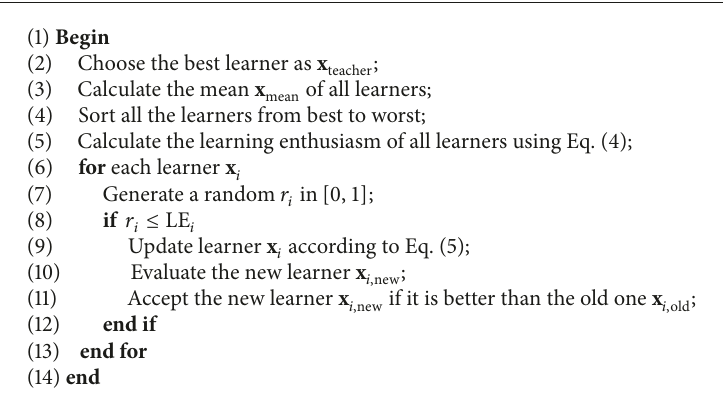
Algorithm 2: Learning enthusiasm based teacher phase.